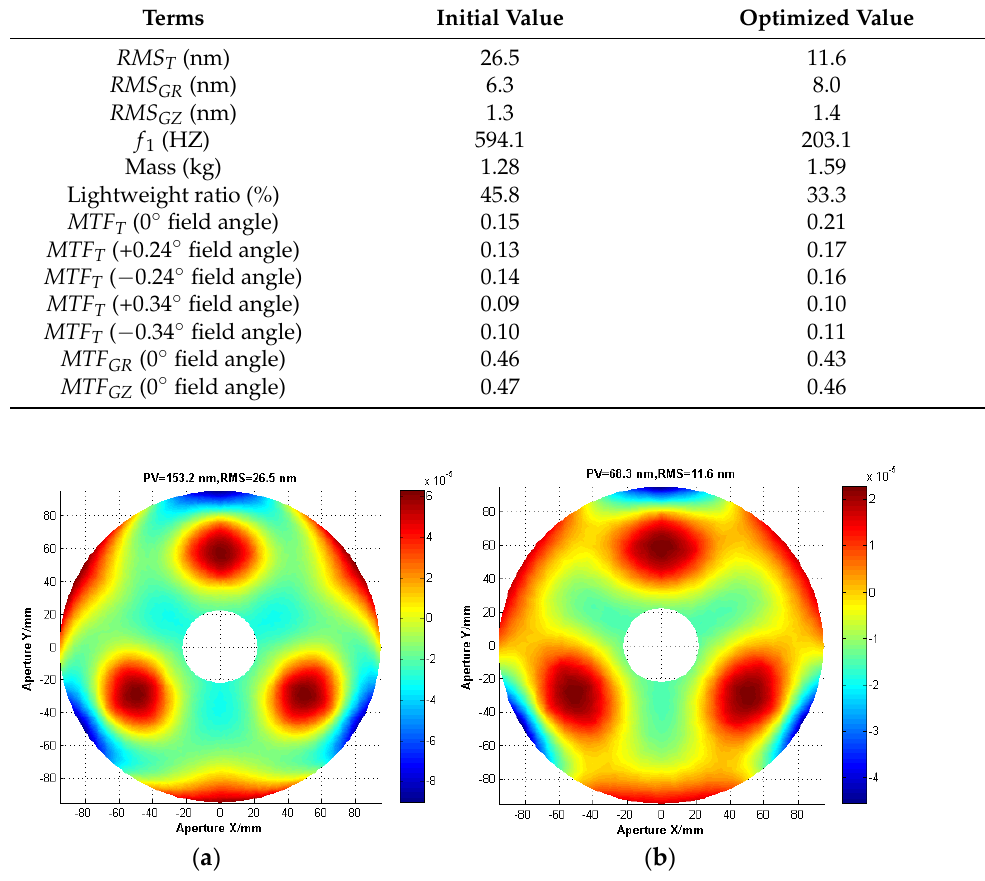
Figure 8. Surface error map under 30 °C uniform temperature decrease. ( a ) Initial design. ( b ) Opti- mized design. mized